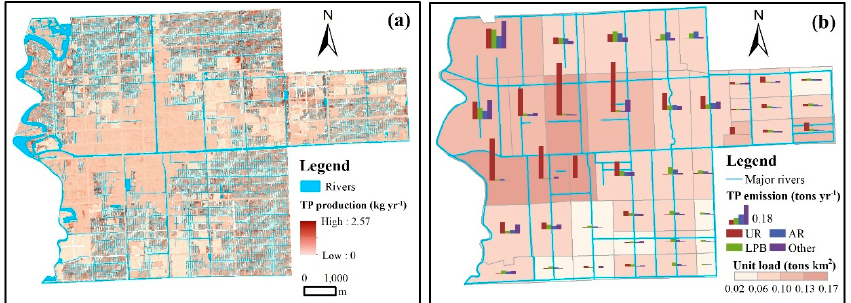
Figure 8. Annual average NPS TP load production per grid ( a ) and emissions into the river in each sub-basin ( b ).